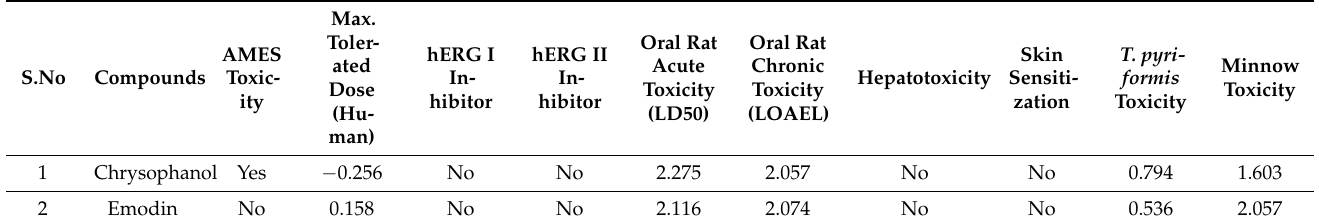
Table 6. Drug-likeness prediction from SwissADME server (MW = Molecular Weight, TPSA = total polar surface area, Consensus Log P = average of all predicted Log Po/w.